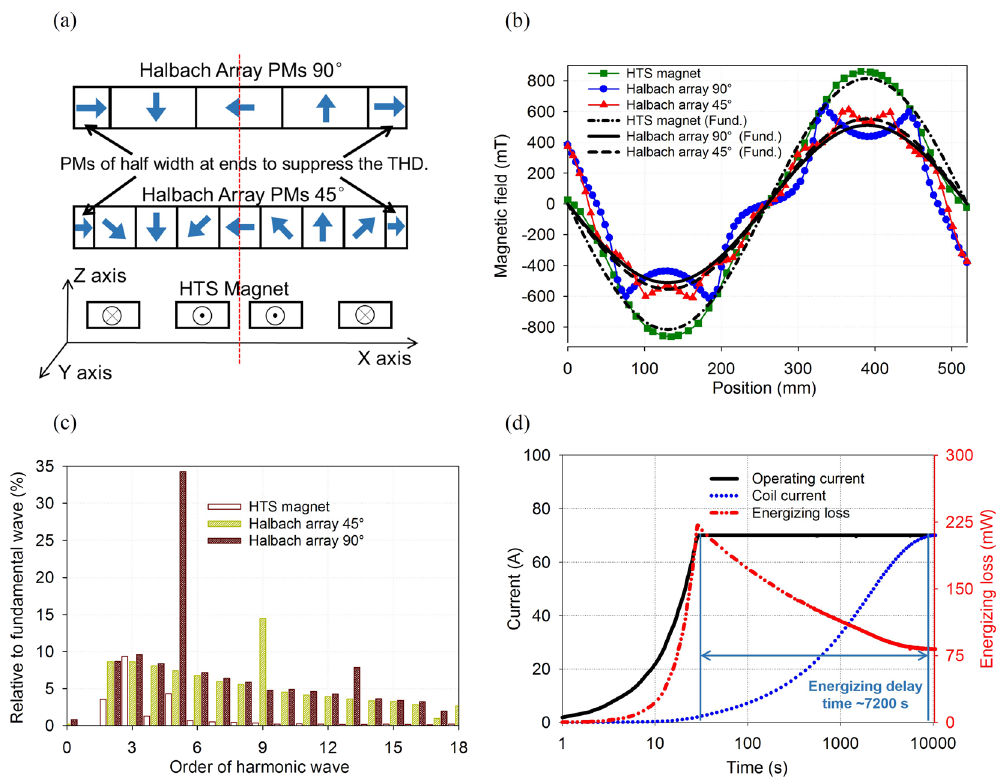
Figure 6. Magnetic and electric performances of the designed magnets. ( a ) The HTS magnets and the Halbach array PMs with magnetization angle of 90° and 45°. Height (Z axis) and length (Y axis) of the Halbach arrays are consistent with the HTS magnets height (including bobbins) and straight part length l r . ( b ) Magnetic field waveforms and their corresponding fundamental components of the HTS magnets and PMs. ( c ) Harmonic analysis of the magnetic fields. ( d ) Energizing characters of the HTS magnets including energizing delay and